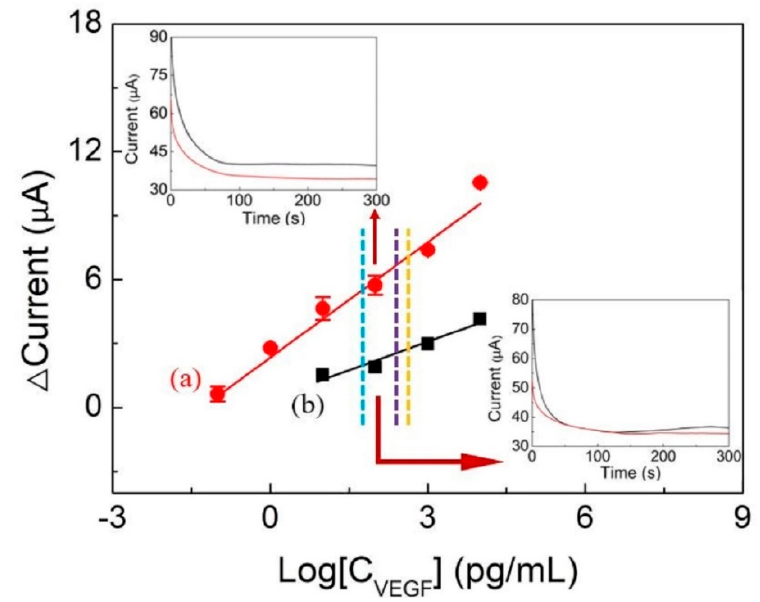
Figure 9. VEGF detection by amperometry using Au/ZnPP/Avastin/BSA electrodes ( a ) (w/LT) and ( b ) (w/o LT) in a 20 mM K 4 Fe(CN) 6 /K 3 Fe(CN) 6 solution. The blue, purple, and orange dotted lines are cut-off levels for breast [5], liver [39], and colorectal cancers [40], respectively. Table 1. Statistical analysis of stability test ( n = 3).